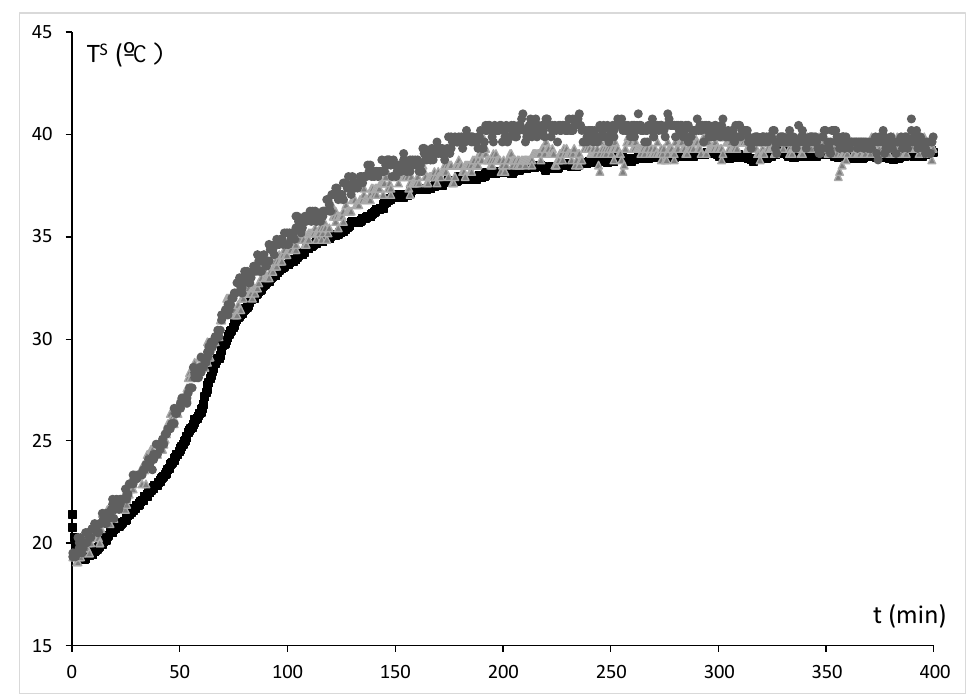
Figure 4. Evolution of surface temperature in the HAD treatment ( ■ ), HAD + 4 W/g treatment ( ▲ ) and HAD + 6 W/g treatment (●).